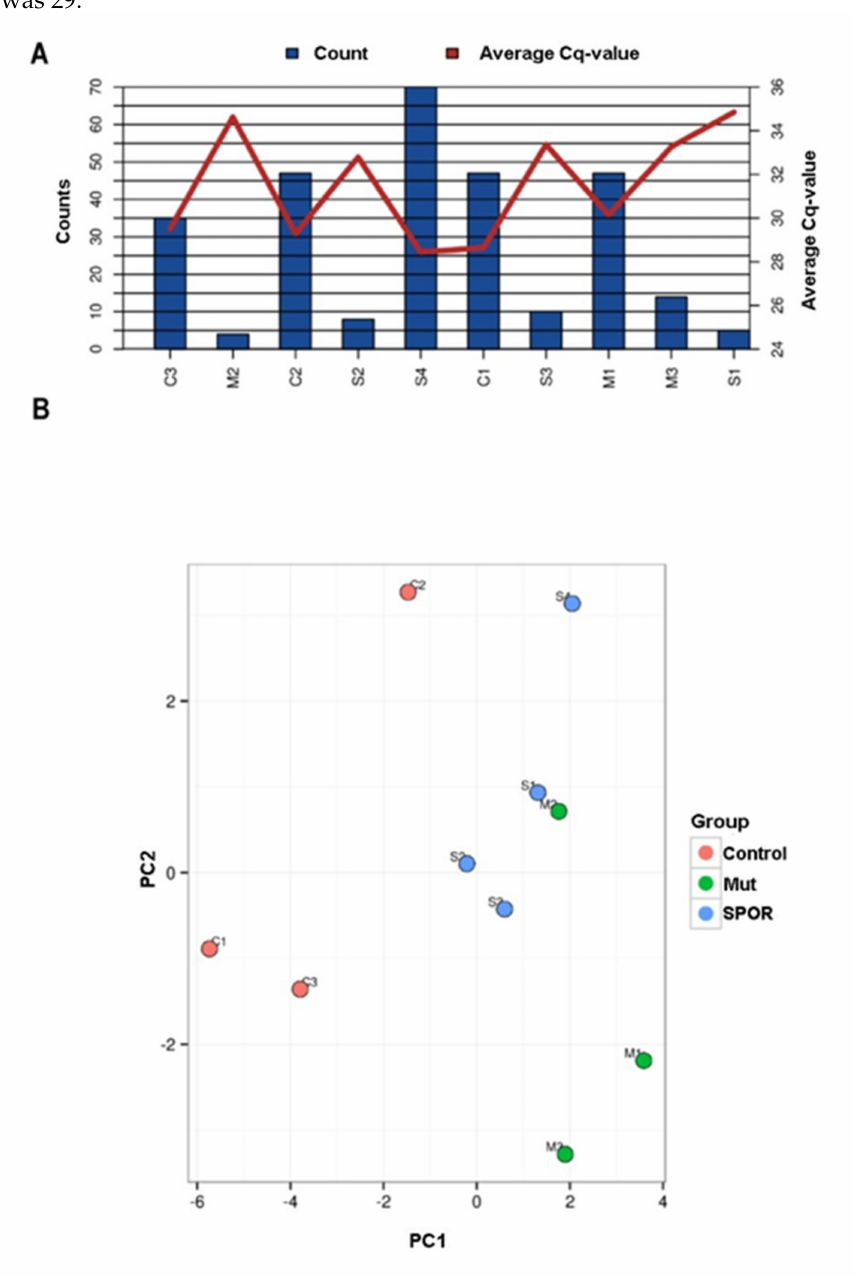
Figure 2. Number of detected miRNAs and PCA. ( A ) Graphical illustration of the miRNA content. The blue bars represent number of miRNAs detected in each sample and the red line shows the average Cq value for the commonly expressed miRNAs. On X axis the analyzed samples are reported (Controls: C1, C2, C3; Sporadic patients: S1, S2, S3, S4 and Mutated patients: M1, M2, M3). ( B ) PCA plot. The principal component analysis is performed on all samples, and on the top 25 miRNAs with highest standard deviation. The normalized (dCq) values have been used for the analysis. The largest component in the variation is plotted along the X axis and the second largest is plotted on the Y